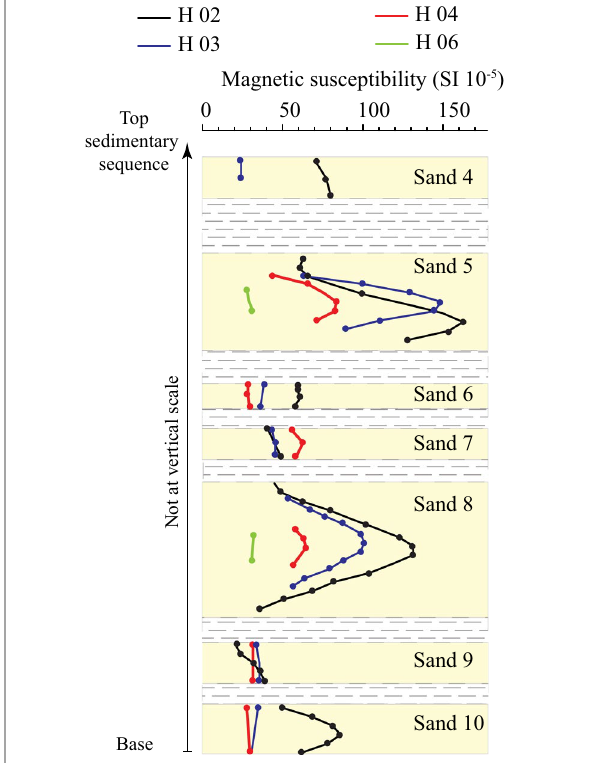
Fig. 5 Magnetic susceptibility landward changes along with the core samples H02, H03, H04, and H06. Note that it is a graphic representation of the MS intensity only in the sand layers, and the thickness of the sand layers is not at scale. MS values of the mud layers were not